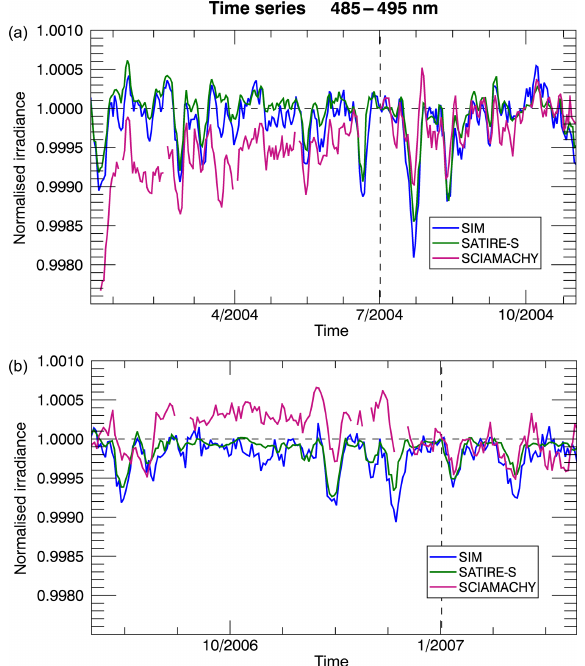
Figure 11. Time series of SSI, integrated into a 10nm wide wave- length band from SCIAMACHY, SIM/SORCE V25, and SATIRE- S. The figure provide a detailed view of 10-month periods in 2004 (a) and 2006/07 (b) . The time series are ratioed to values from 1 July 2004 and 1 January 2007, respectively, to shift the data sets for better